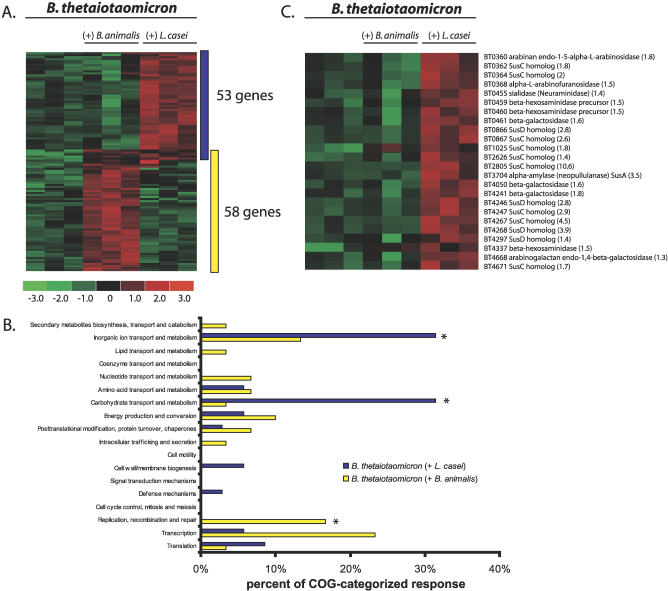
Changes in the B. thetaiotaomicron Transcriptome in Response to Co-colonization with B. animalis or L. casei
(A) B. thetaiotaomicron genes that show significantly increased expression levels upon co-colonization with either of the two fermented dairy product–associated strains are shown. Selection criteria: (1) a 1.2-fold or greater difference in expression using the 90% confidence bound of the fold-change; (2) difference in signal ≥ 25; (3) p-value ≤ 0.025 using Student t-test; (4) transcript called “present” in 66% or more of the GeneChips in the co-colonized group; and (5) a median FDR less than 0.05 based on 50 permutated comparisons.(B) COG-based functional classification of genes identified in (A). Thirty-five of 53 genes with higher expression in the presence of L. casei and 30 of 58 genes with higher expression in the presence of B. animalis could be assigned to COGs. Functional categories with significant over-representation in the dataset of differentially expressed genes, compared to their representation in the B. thetaiotaomicron genome, were determined using a hypergeometric distribution; an asterisk (*) indicates p < 0.01.(C) All B. thetaiotaomicron SusC/D paralogs and glycoside hydrolases/polysaccharide lyases that show differential expression between the three colonization states are up-regulated in the presence of L. casei. Fold-differences are indicated in parenthesis and reflect average expression across three cecal samples when B. thetaiotaomicron is co-colonized with L. casei, compared to their average expression in three cecal samples obtained from B. thetaiotaomicron mono-associated animals.